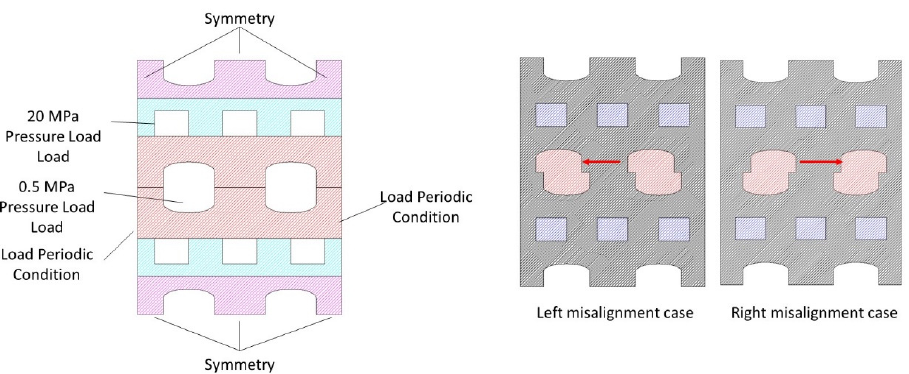
Figure 2. Applied boundary conditions for numerical simulation.